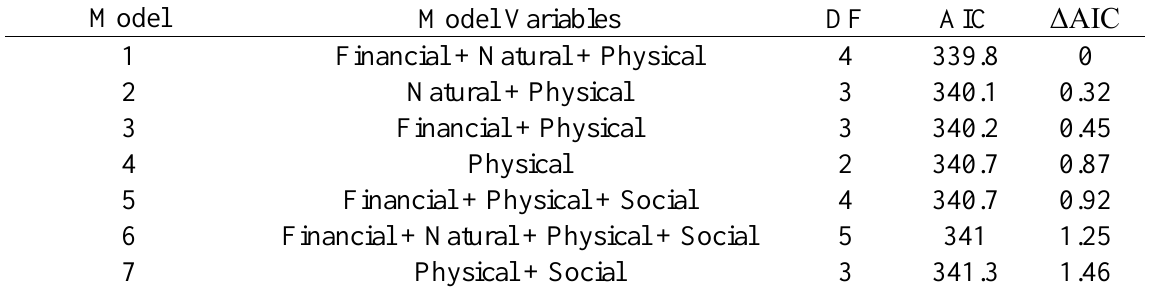
Table A2.3 Akaike information Criteria (AIC), change in AIC (ΔAIC) and degrees of freedom (df) from the top competing regression models of household adaptation success ratio as a function of types of household capital.